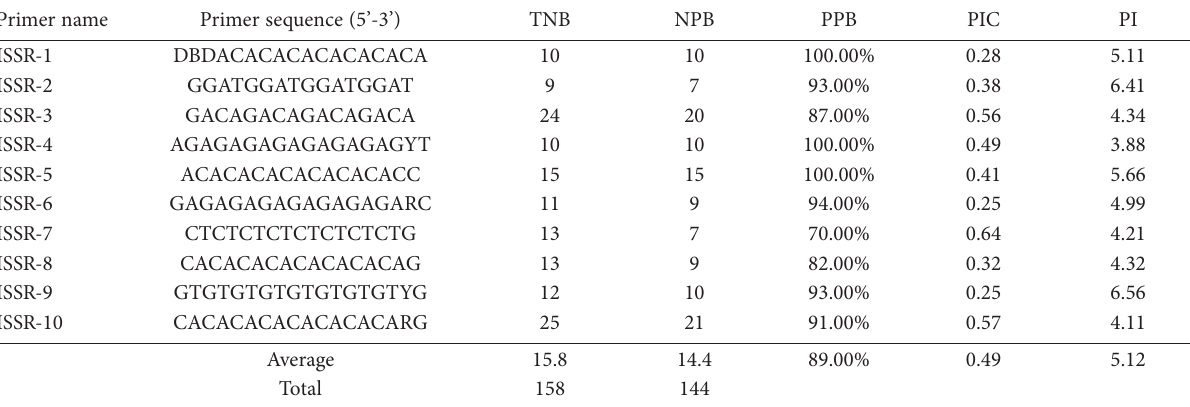
Table 2. Details about the banding pattern revealed by ISSR primers. Primer